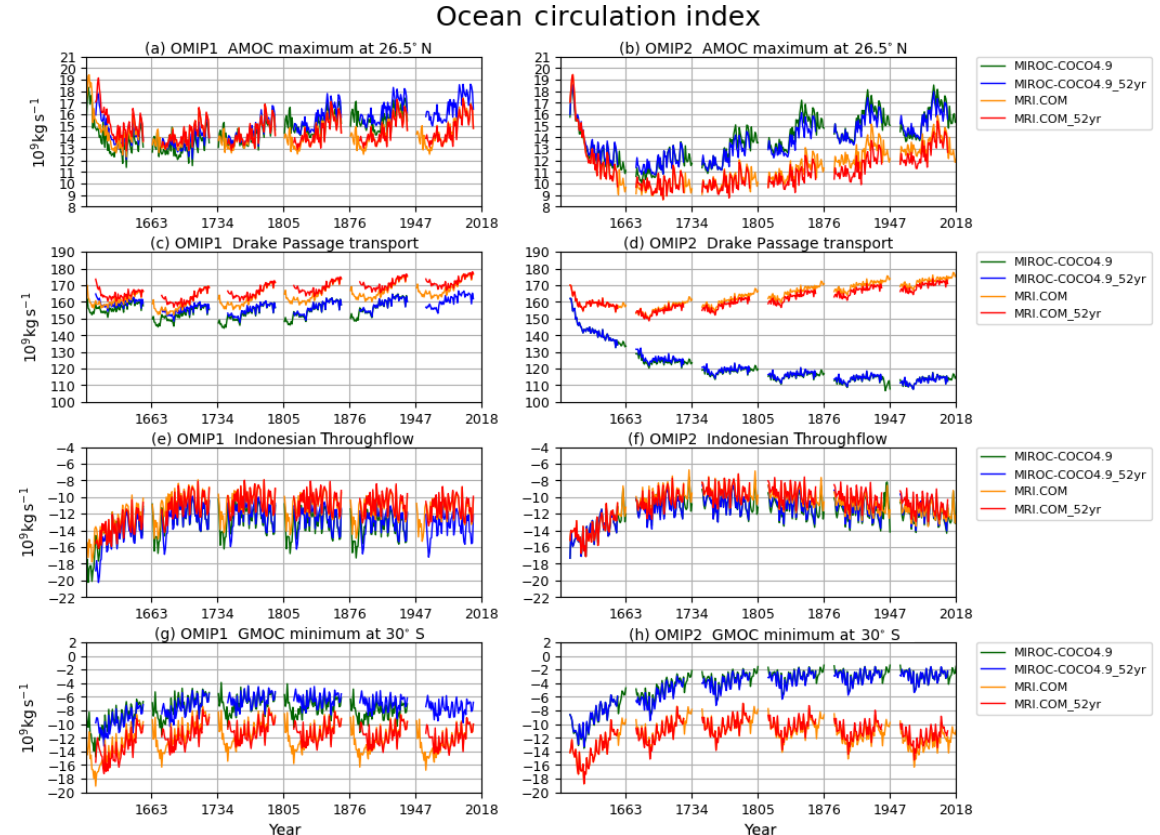
Figure B2. Time series of annual mean ocean circulation metrics of the two sets of OMIP-1 and OMIP-2 simulations differing in the period used for repeating conducted by two models (MIROC-COCO4.9 and MRI.COM). MIROC-COCO4.9 simulations using the full period (1948–2009 for OMIP-1 and 1958–2018 for OMIP-2) for repeating (green). MIROC-COCO4.9 simulations using the common period of OMIP-1 and OMIP-2 forcing (1958–2009) for repeating (blue). MRI.COM simulations using the full period (orange) and MRI.COM simulations using 1958–2009 (red). (a, b) AMOC maximum at 26.5 ◦ N. (c, d) Drake Passage transport (positive transport eastward). (e, f) Indonesian Throughflow (negative into the Indian Ocean). (g, h) GMOC minimum between 2000m and the bottom at 30 ◦ S. Units are 10 9 kgs − 1